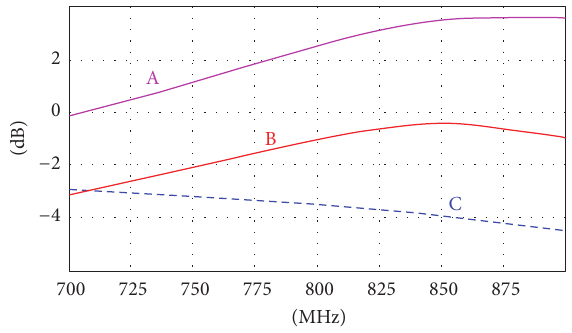
Figure 12: Insertion gain (curve A), transducer power gain (curve B), and mismatch factor without the antenna tuner (curve